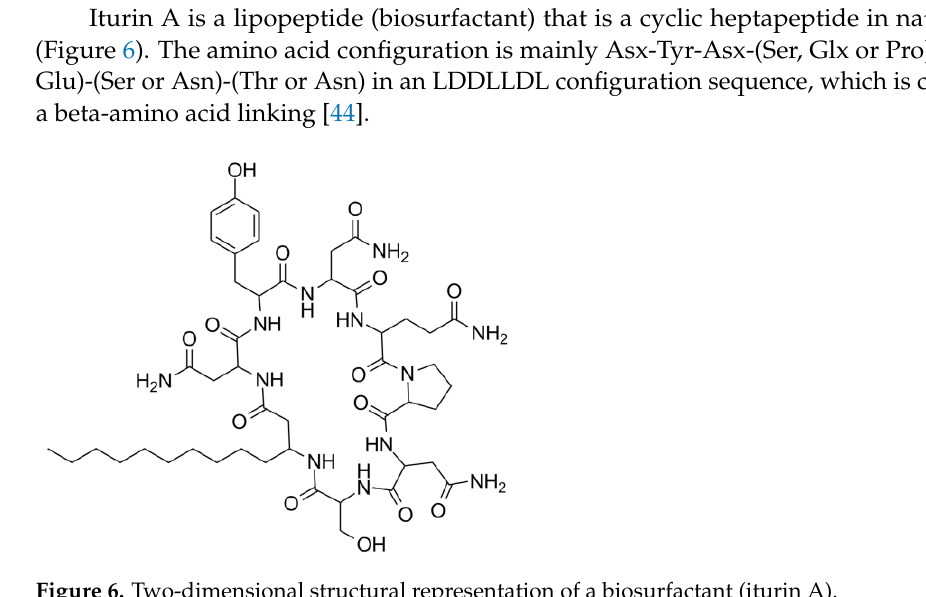
Figure 6. Two-dimensional structural representation of a biosurfactant (iturin